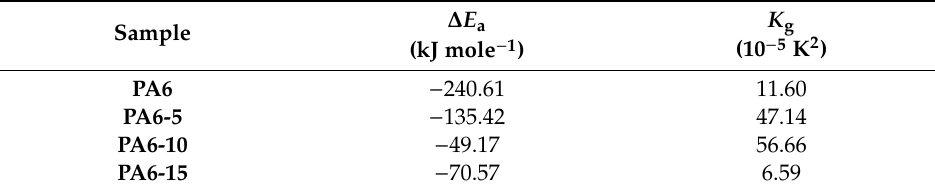
Table 3. The activation energies and nucleation parameters of the Lauritzen–Ho ff man method.